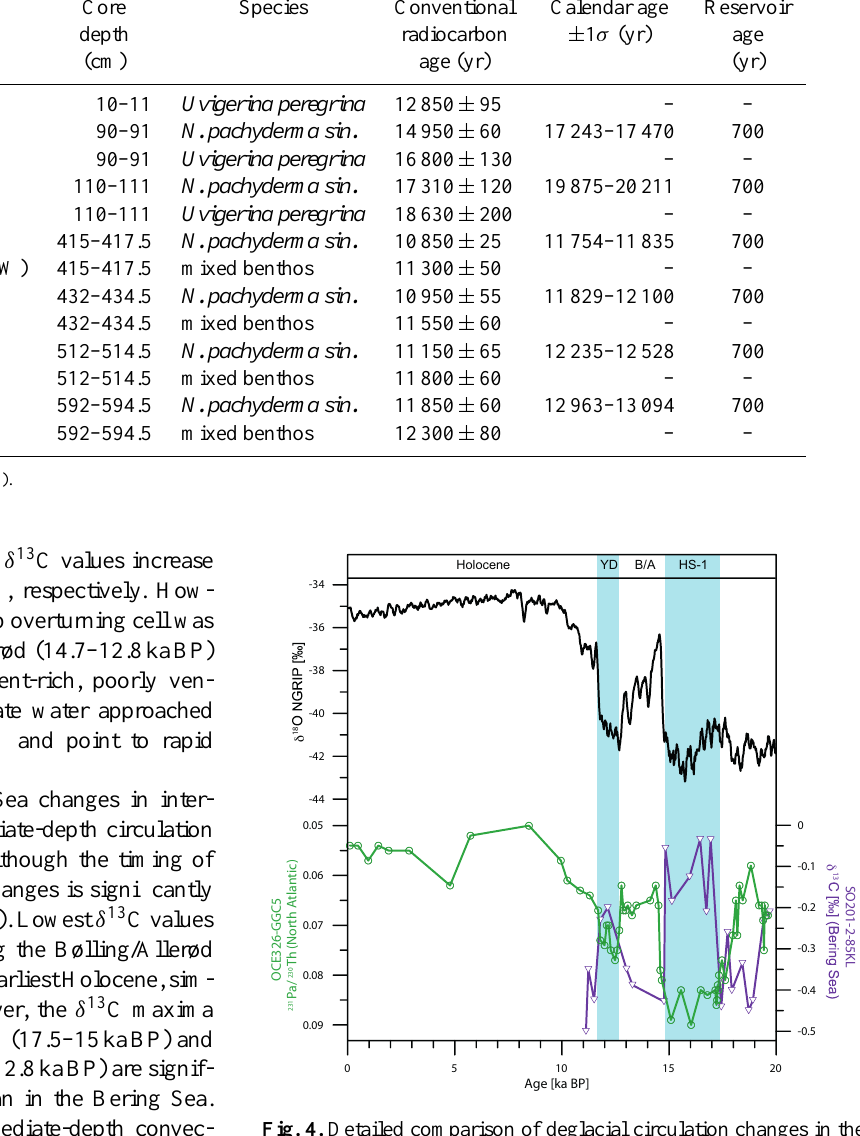
Fig. 4. Detailed comparison of deglacial circulation changes in the North Atlantic and western Bering Sea during the past 20kyr. Given are the Pa / Th ratio as proxy for the AMOC strength in the North Atlantic (in green) (McManus et al., 2004) compared to the western Bering Sea intermediate-depth δ 13 C record (in purple) as proxy for circulation changes in the North Pacific. Blue shaded areas mark stadial HS-1 and the YD. For comparison, the NGRIP ice core record (in black) is given on top (Rasmussen et al., 2006).